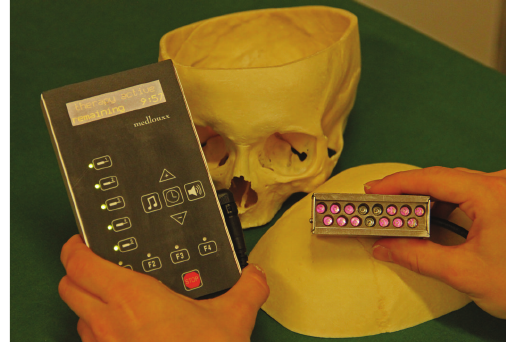
Figure 3: The medlouxx system including the LED applicator.